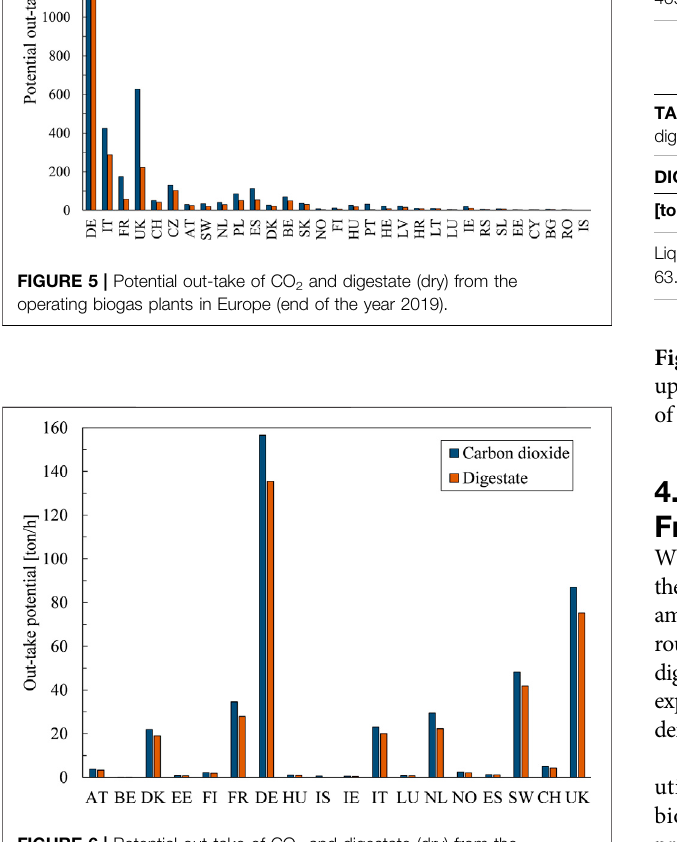
FIGURE 6 | Potential out-take of CO 2 and digestate (dry) from the operating biomethane plants in Europe (end of the year 2019).